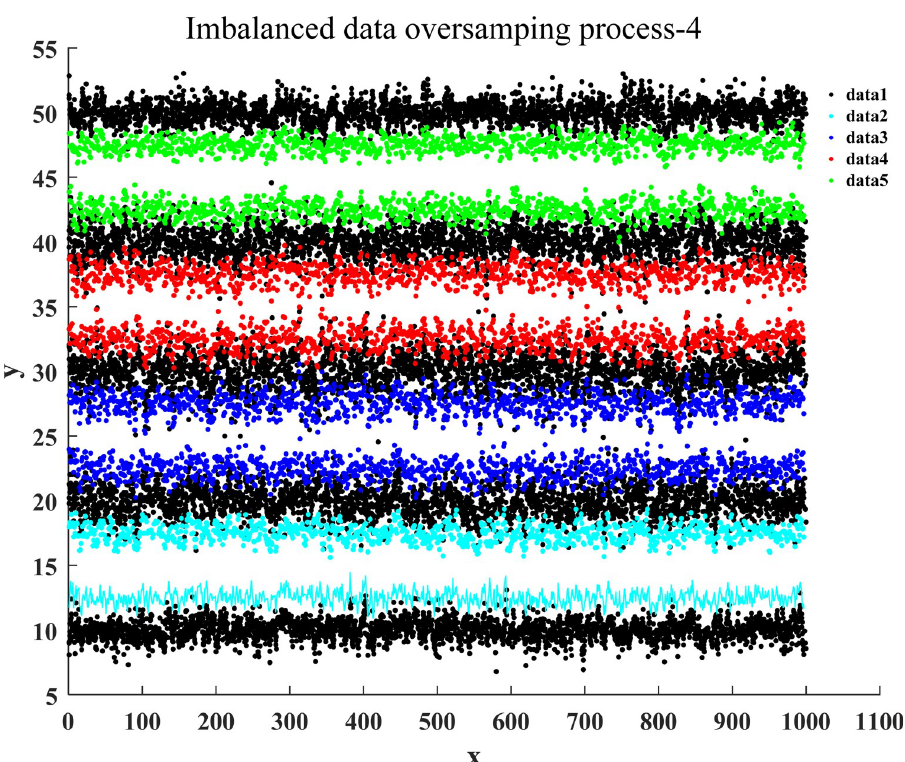
Fig 7. Inter-class sampling of oversampling for imbalanced